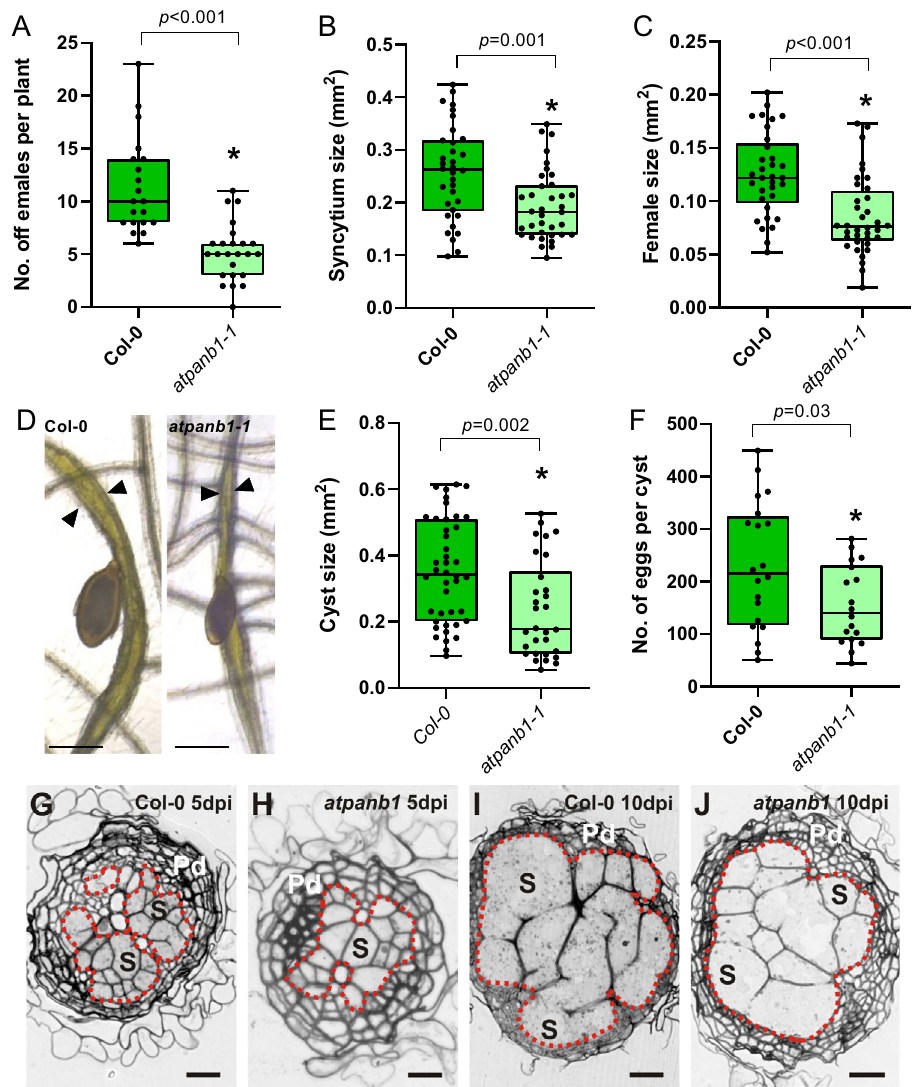
Fig. 7 | AtPANB1 is required for cyst nematode parasitism. A Number of female cyst nematodes present per plant root system at 14 dpi (Col-0, n =20; atpanb1-1 , n =24). B Size of syncytia at 14 dpi. Female-associated syncytia were randomly selected and their outlines were measured (Col-0, n =33; atpanb1-1 , n =36). C Size offemalenematodesat14dpi.Femalecystnematodeswererandomlyselectedand theiroutlinesweremeasured(Col-0, n =33; atpanb1-1 , n =36). D Exampleimagesof nematode infection on Col-0 and atpanb1-1 mutants. Arrowheads indicate syncy- tiumboundariesand asterisksindicate female nematodes. E Sizeof cysts at 42dpi. Nematode cysts were randomly selected and their outlines were measured (Col-0, n =43; atpanb1-1 , n =32). F Numberofeggspercystat42dpi.Cystswererandomly selected and their egg numbers were counted (Col-0, n =20; atpanb1-1 , n =19).